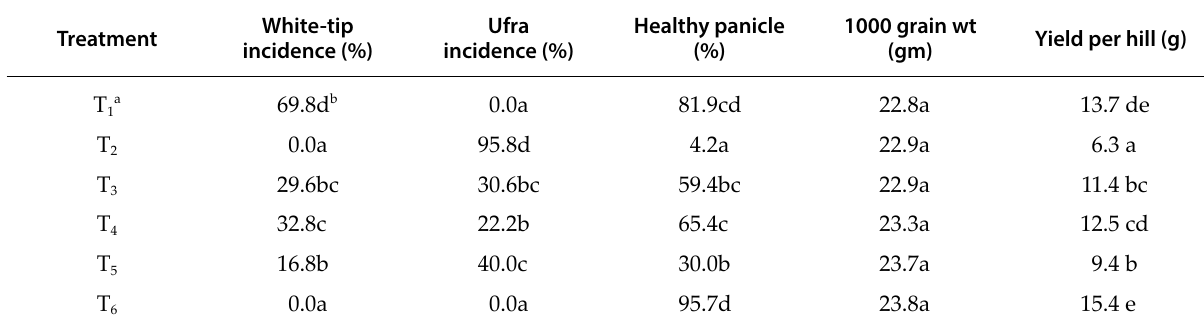
Figure 3. Mean reproduction rates of Aphelenchoides besseyi and Ditylenchus Angustus in pots and field. Treatment (T), A. bes- seyi : D. angustus inoculation ratios, T1 = 100:0; T2 = 0:100; T3 = 50:50; T4 = 75:25; T5 = 25:75; A = A. besseyi ; D= D. angustus . Vertical bars indicate standard errors. Table 3A. Mean disease incidence, yield components and yields of rice plants inoculated with different ratios of Aphen- choides besseyi and Ditylenchus angustus in the pot